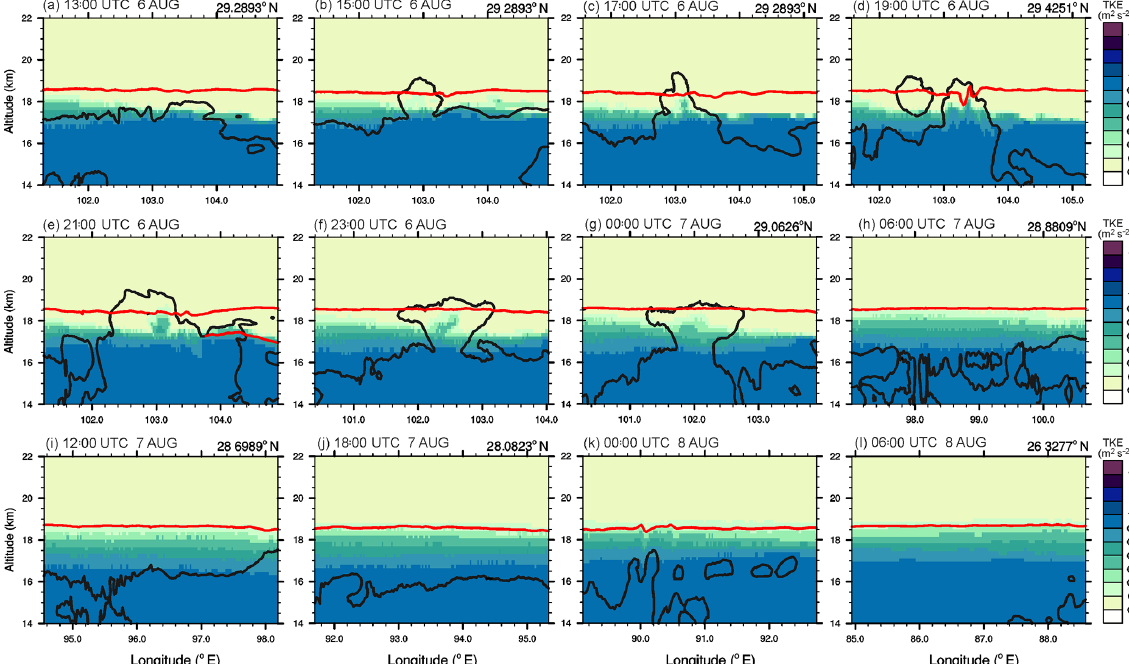
Figure 9. Same as Fig. 6 but for the TKE. The isentropic altitude of 410K is depicted by the red line.